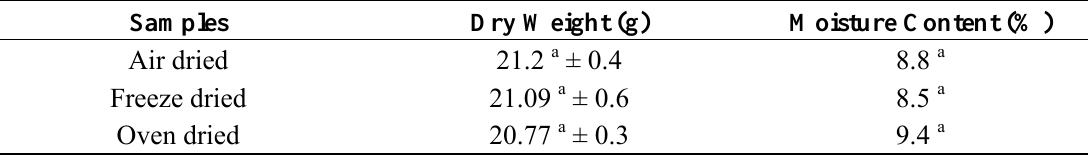
Table 1. Dry weight and moisture content of samples processed by three drying